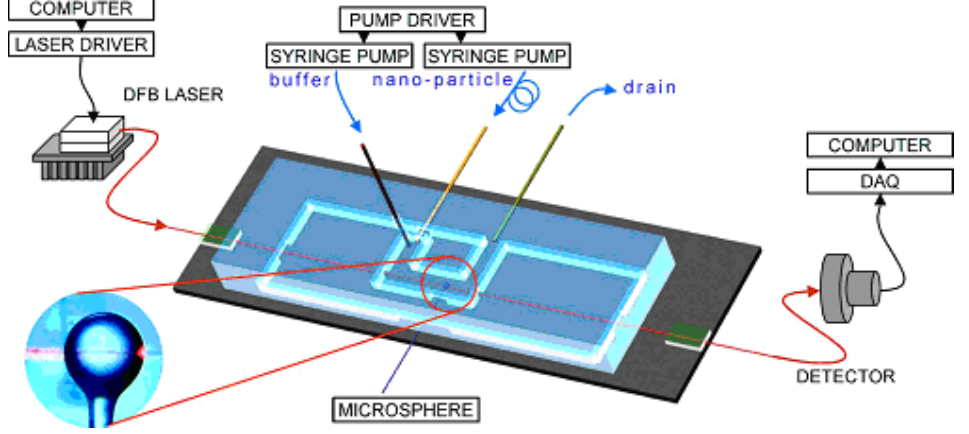
Figure 10. Integrated WGMR and microfluidic system for biosensing. Reprinted with permission from [59] © 2007, American Institute of